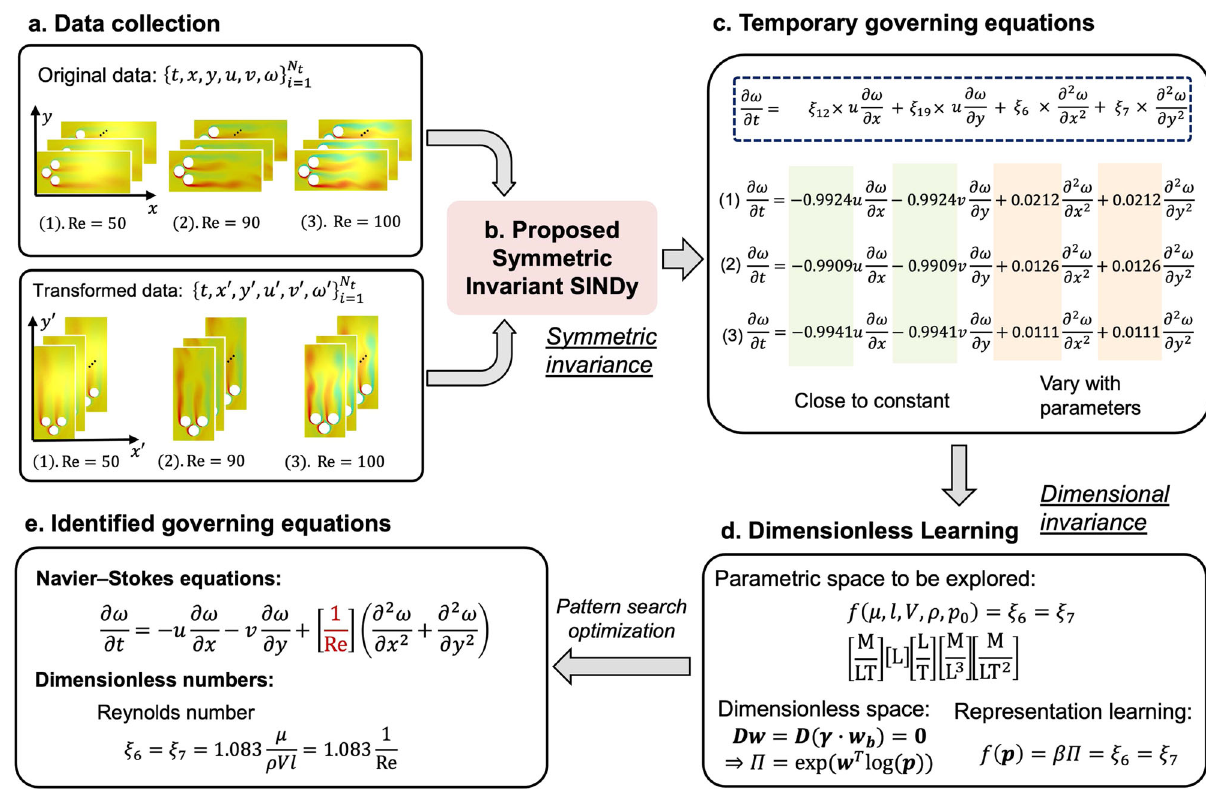
Fig. 4 | Integration of dimensionless learning with symmetric invariant SINDy for identifying the Navier – Stokes equation with Reynold number. a Original data are generated fromparametric simulations. Toachieve symmetric invariance, anothersetoftransformeddataisobtainedby fl ippingtheoriginaldataalong y = x . b The original and transformed data are concatenated for symmetric invariant SINDy, which implicitly incorporates symmetric invariance into SINDy to ensure that symmetric invariant terms have the same coef fi cients. c The identi fi ed tem- porary governing equations for each simulation case were obtained by optimizing thesymmetricinvariantSINDy.Someofthecoef fi cientsareclosetoconstant,while